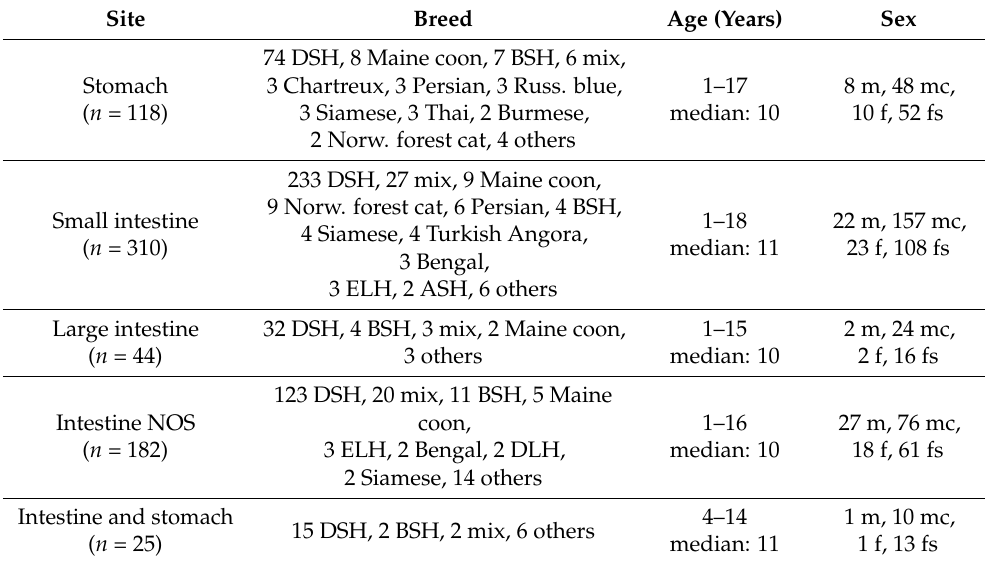
Legend: ASH = American shorthair; BSH = British shorthair; DLH = domestic long-haired cat; DSH = do- mestic short-haired cat; ELH = exotic long-haired cat; f = female; fs = female spayed; m = male; mc = male castrated; mix = mixed breed; Norw. forest cat = Norwegian forest cat; NOS = not otherwise specified; Russ. blue = Russian